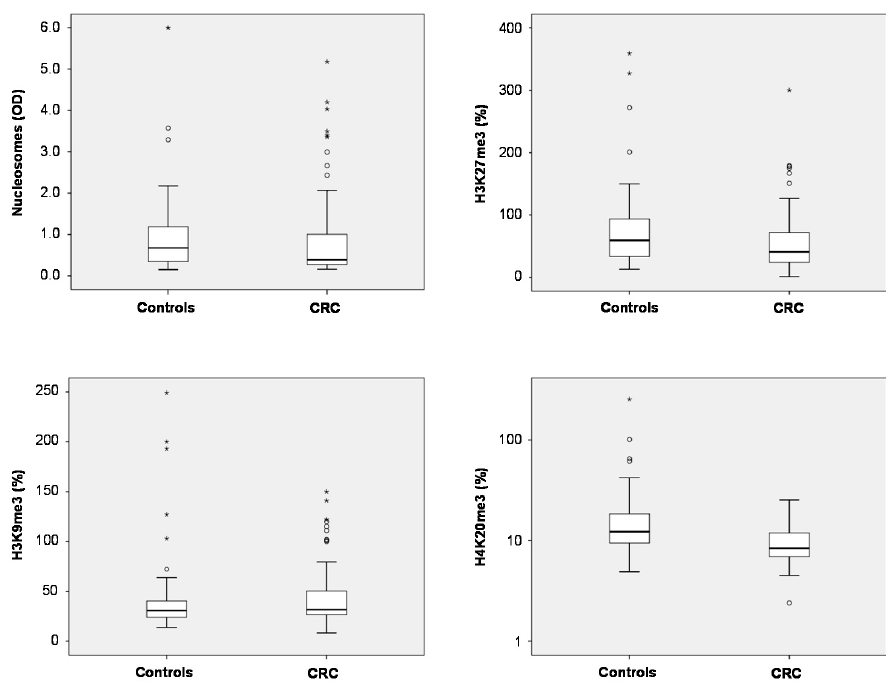
Figure 1. Box plots indicating median, interquartile ranges, whiskers and ranges for nucleosomes, H3K9me3, H3K27me3 and H4K20me3 in patients with colorectal cancer (CRC) and non-malignant controls. Among the significant discriminating markers, H3K27me3 achieved an AUC of 0.620 (95% confidence interval (CI) = 0.512–0.728) and sensitivities for CRC detection of 17.5% at 95% and 31.7% at 90% specificity vs. controls, while H4K20me3 had an AUC of 0.715 (CI = 0.613–0.818) and a sensitivity of 14.3% at 95% and of 36.5% at 90% specificity. When combining histone marks, H4K20me3 and H3K9me3 did not increase the AUC (0.714; CI = 0.612–0.816). However, H4K20me3 and H3K27me3 clearly showed superior results with an AUC of 0.769 (CI = 0.679–0.860) and sensitivities of 28.6% at 95% and of 49.2 at 90% specificity (Figure 2).